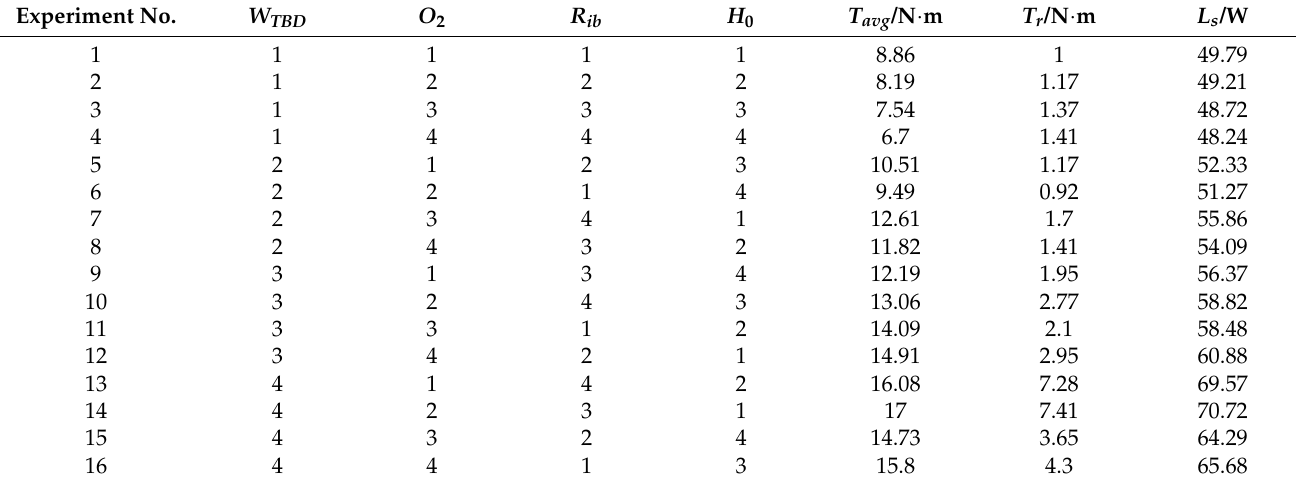
Table 4. L 16 ( 4 4 ) orthogonal